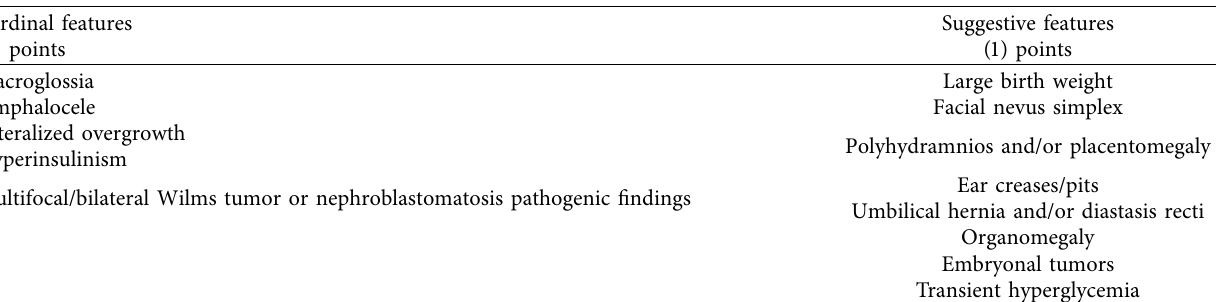
Table 4: BWS clinical diagnosis